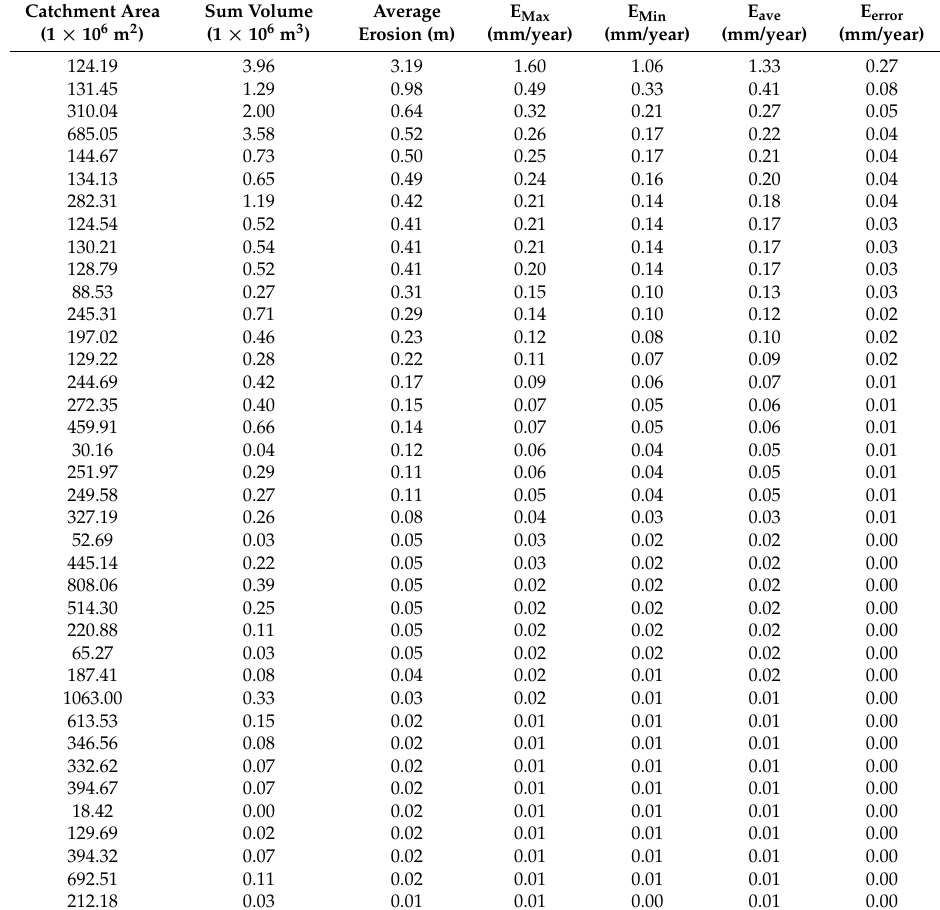
Table 3. Seismically-induced erosion rates derived from the landslide volume data of Li et al. [11] within each of the catchments shown in Figure